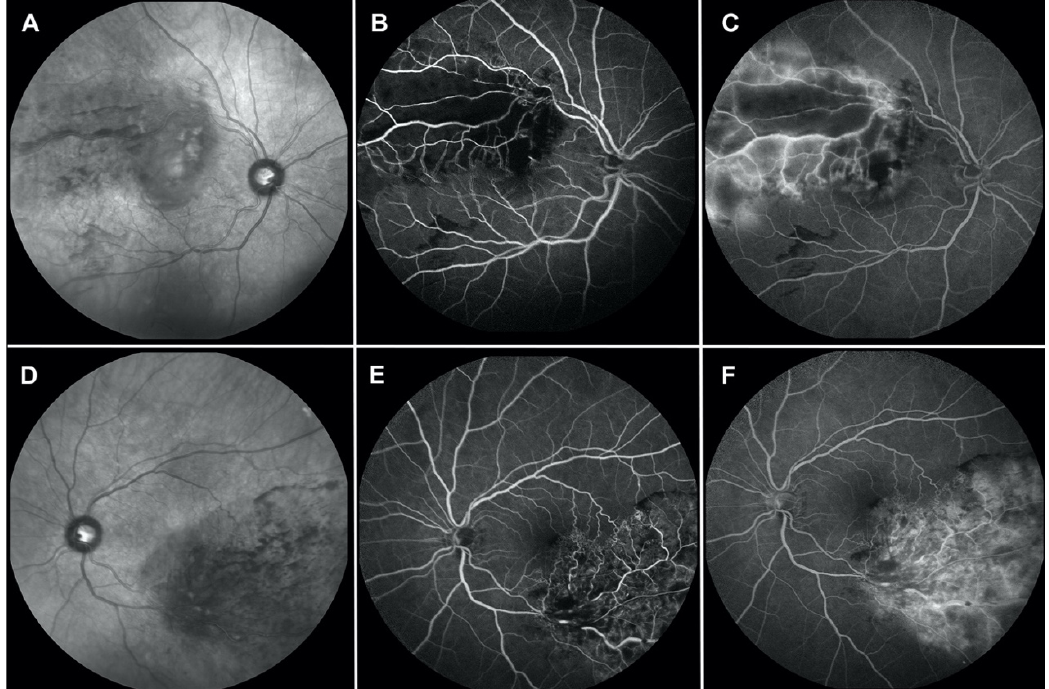
Figure 2. Fundus autofluorescence (FAF) and fluorescein angiography (FA) of both eyes at three weeks follow-up. FAF of the right ( A ) and left ( D ) eyes hyper-autofluorescence corresponding to intraretinal fluid near the fovea and hypo-autofluorescence as a result of blockage intraretinal hemorrhage. FA shows ischemic branch retinal vein occlusion with blockage corresponding to the retinal hemorrhage in early phases (( B ), right and ( E ), left). Late phases showed extensive leakage in the area of branch retinal vein occlusion and clinically significant macular edema (( C ), right and ( F ), left). Arm-retina time, 16 s; Right eye arteriovenous transit time, 42 s; Left eye arteriovenous transit time, 32 s.